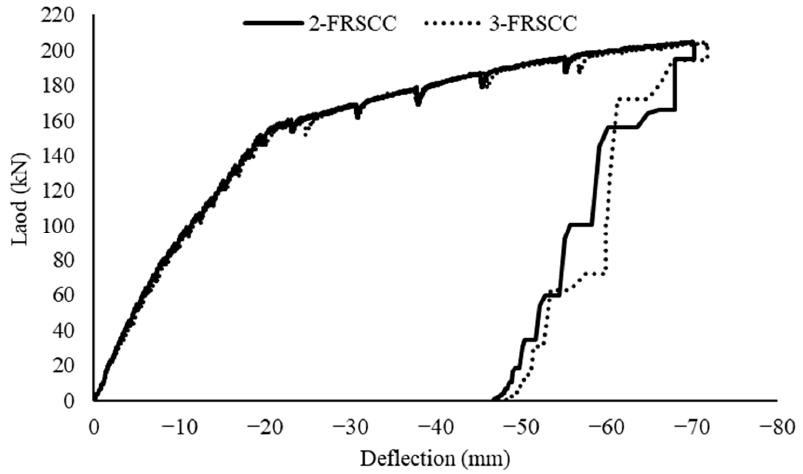
Figure 15. Load vs. deflection plot for connected girder specimens repaired with FRSCC.